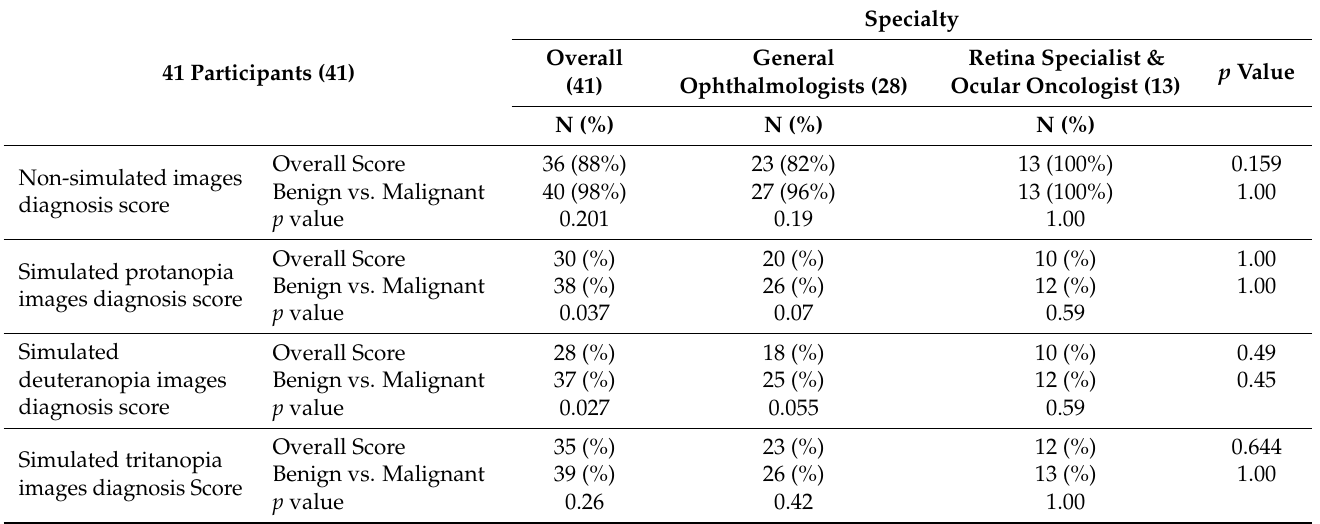
Table 2. Comparing accuracy in diagnosing simulated and non-simulated images between general ophthalmologists on one side and retina specialists and ocular oncologists on the other